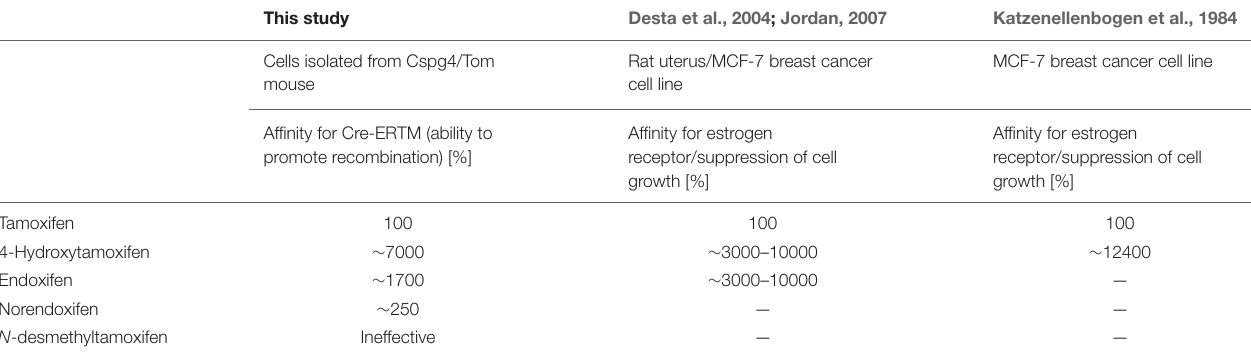
TABLE 1 | Comparison of biological activity of tamoxifen and its metabolites determined in this study and in Katzenellenbogen et al. (1984), Desta et al. (2004), and Jordan (2007). This